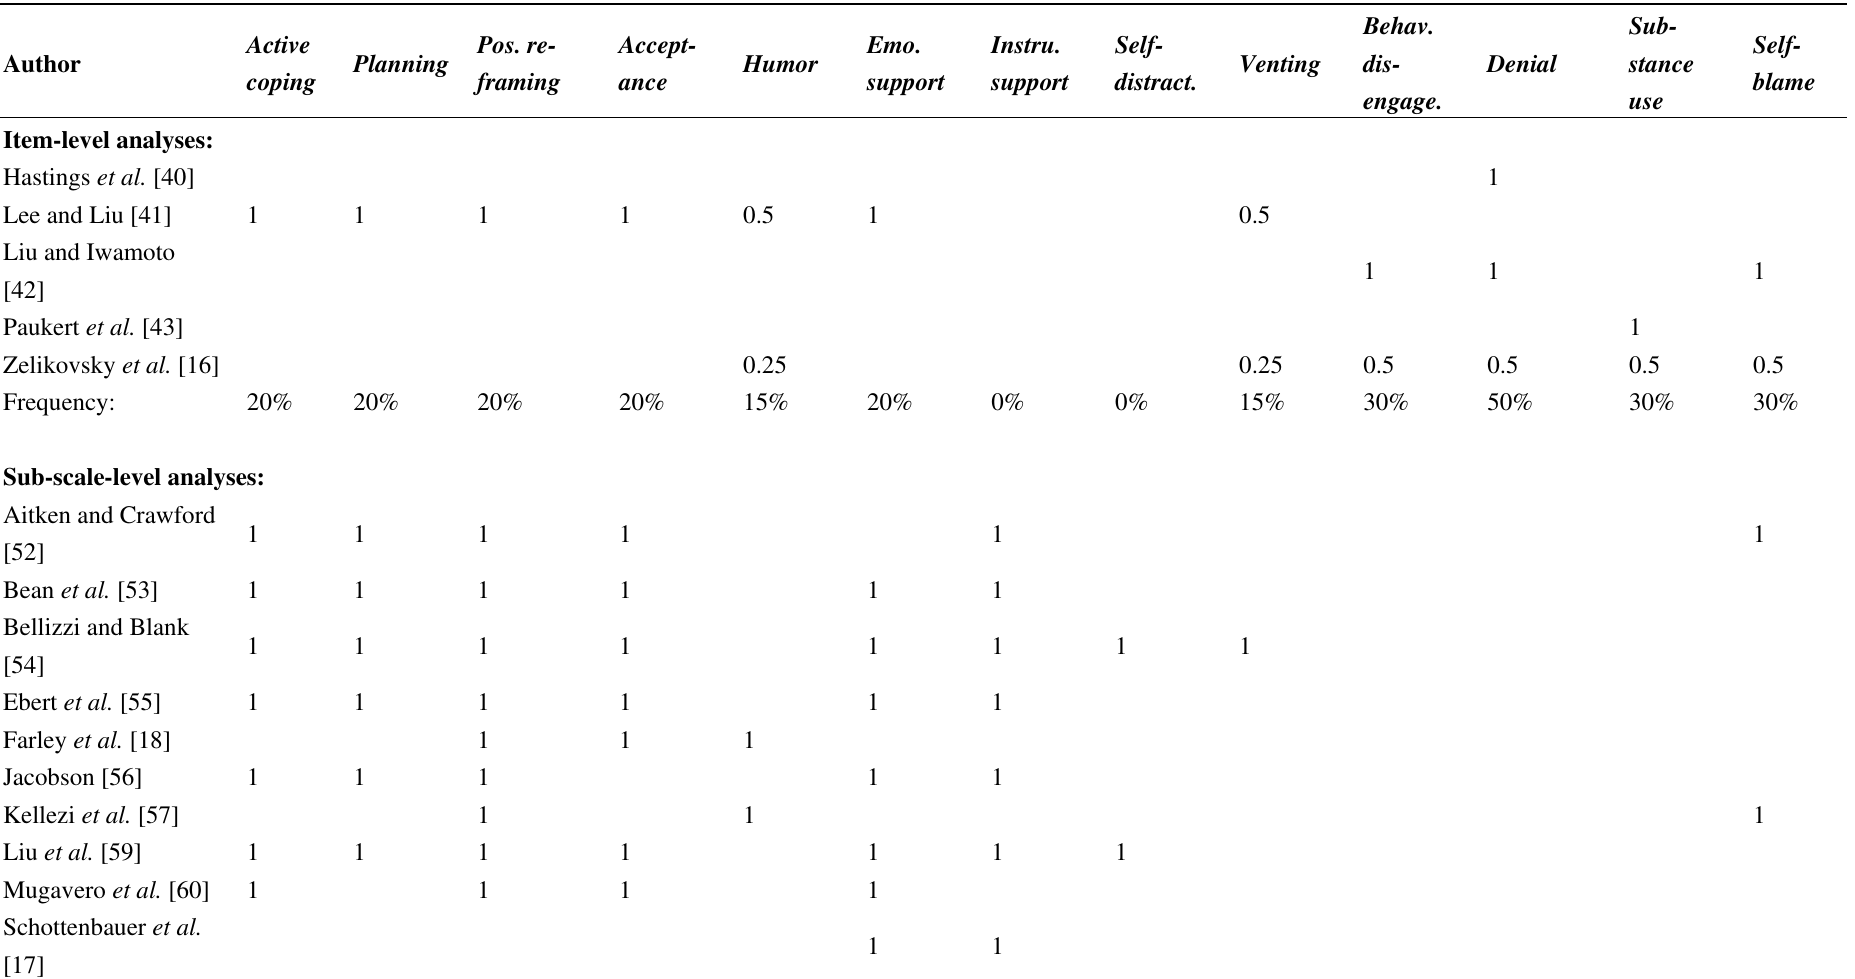
Table 4. Summary of factor loading of turning to religion with the other 13 sub-scales from the Brief COPE [1], presented separately for studies that conducted exploratory factor analyses at item level, those that conducted factor analyses at sub-scale level, and those that used factor structures based on previous research or theoretical considerations. Note that Steinhardt and Dolbier [61] reported that turning to religion loaded together with the negatively scored sub-scale substance use , but no entry was made in that